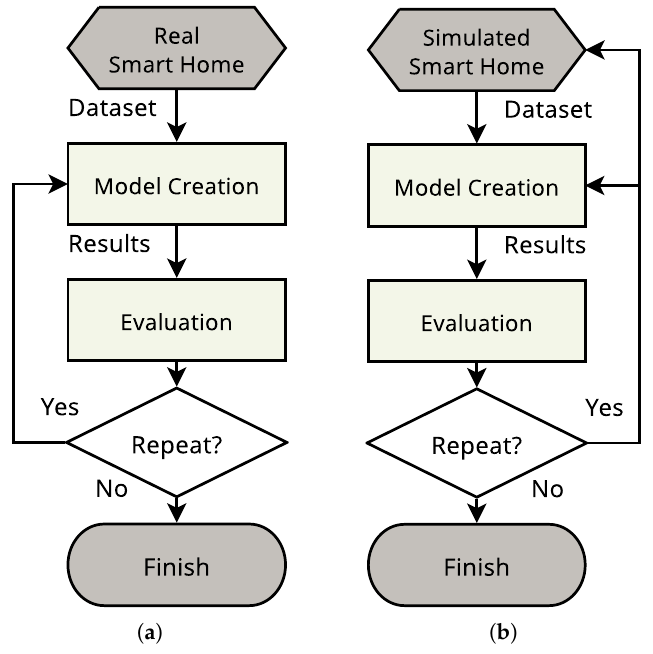
Figure 1. The workflow of real and simulated smart homes test beds. ( a ) A real test bed; ( b ) a simulated test